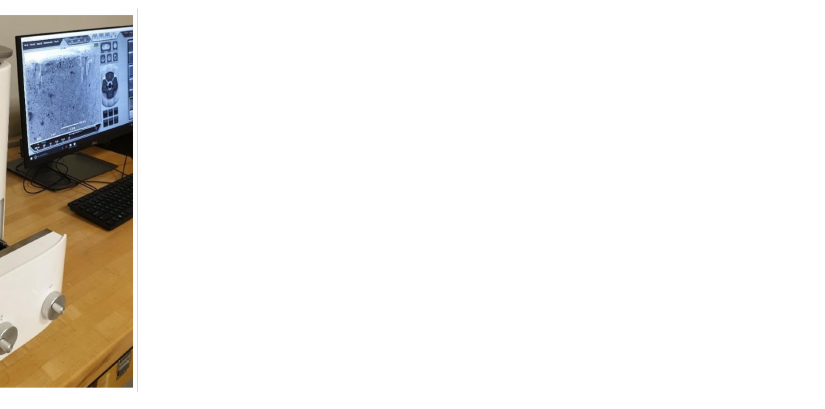
Figure 4. Scanning electron microscope setup for observing surface morphology.